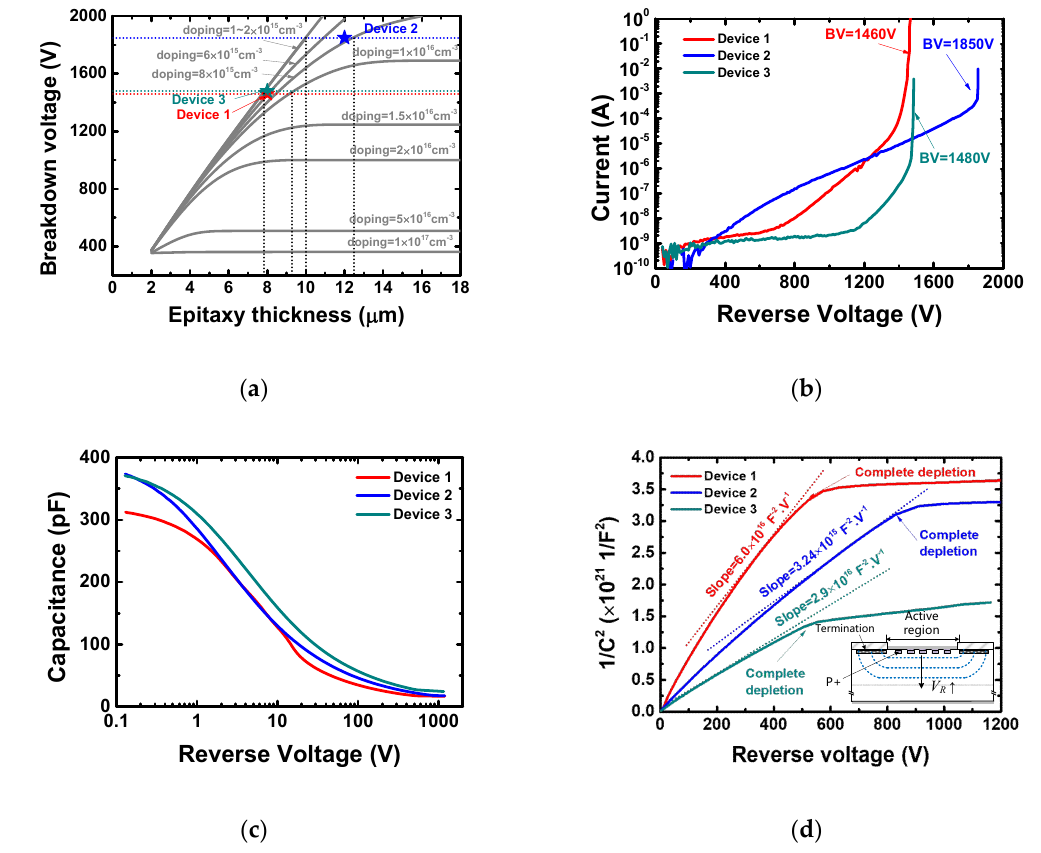
Figure A1. ( a ) The dependence of the breakdown voltage ( BV ) on the epitaxy layer thickness ( t epi ) and doping concentration ( N epi ) by simulation. ( b ) The measured reverse I–V characteristics, ( c ) the measured capacitance–voltage (C-V) characteristics, and ( d ) the 1 / C 2 -V curves of the three devices. The inset in ( d ) shows the extension of the depletion region as the reverse bias voltage ( V R )